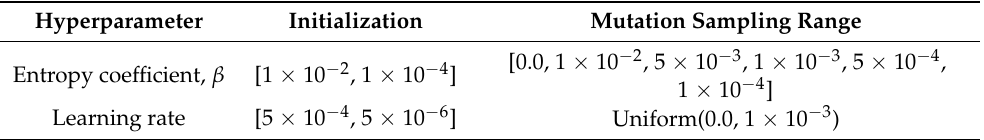
Table 5. Initialization and mutation range of hyperparameters for hyperparameter optimization with population-based